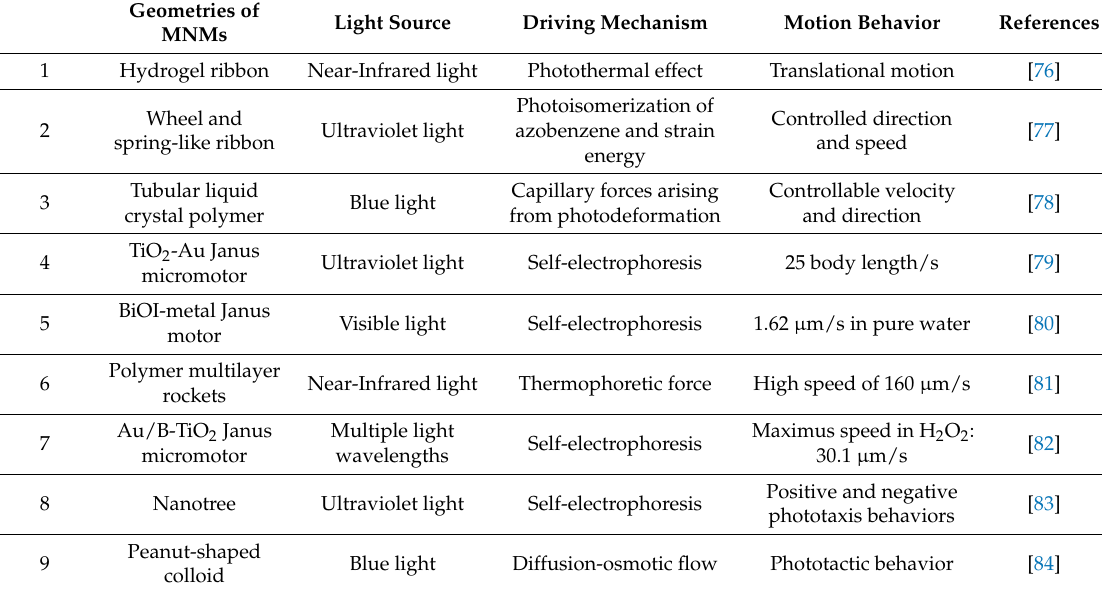
Table 1. Typical geometries, light sources, driving mechanisms and motion behaviors of light-powered